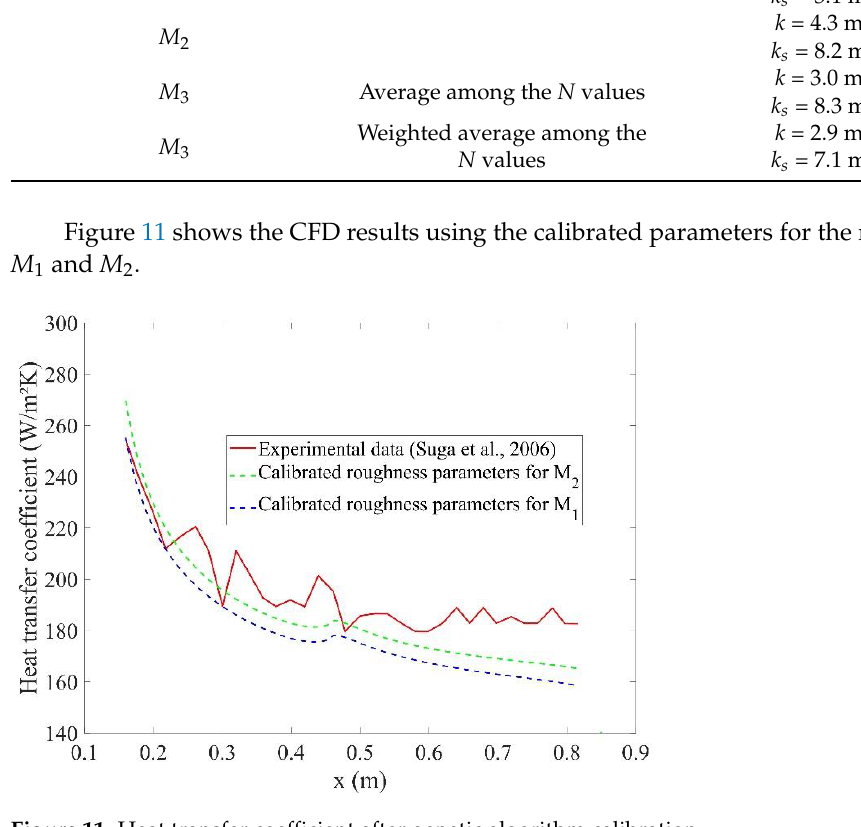
Figure 12. PCE and CFD predictions using M 3 calibrated values (genetic algorithm). 7.7. Comparison of Both Calibration Methods After calibrating the metamodels using both Bayesian inversion and genetic algo- rithm approaches, the first comparison is the capacity for predicting the experimental data. This comparison is made by computing the mean relative error compared with ex- perimental data. Table 9 gathered together the mean relative errors for both approaches. Table 9. Errors with experimental data for each calibration. Calibrated Metamodel h c Mean Relative Error with Experimental Data Bayesian Inversion